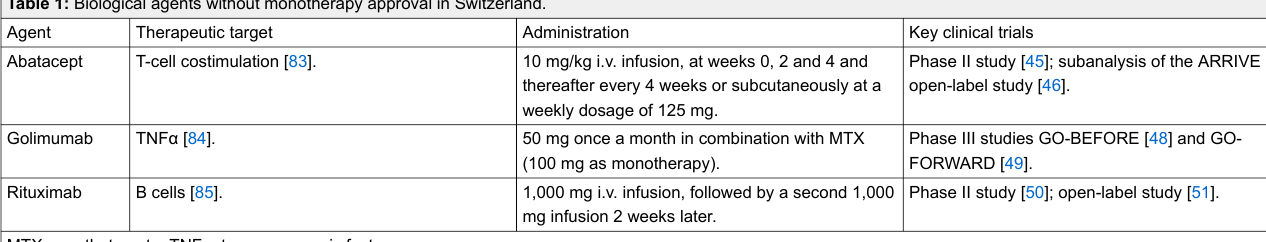
Table 1: Biological agents without monotherapy approval in Switzerland.